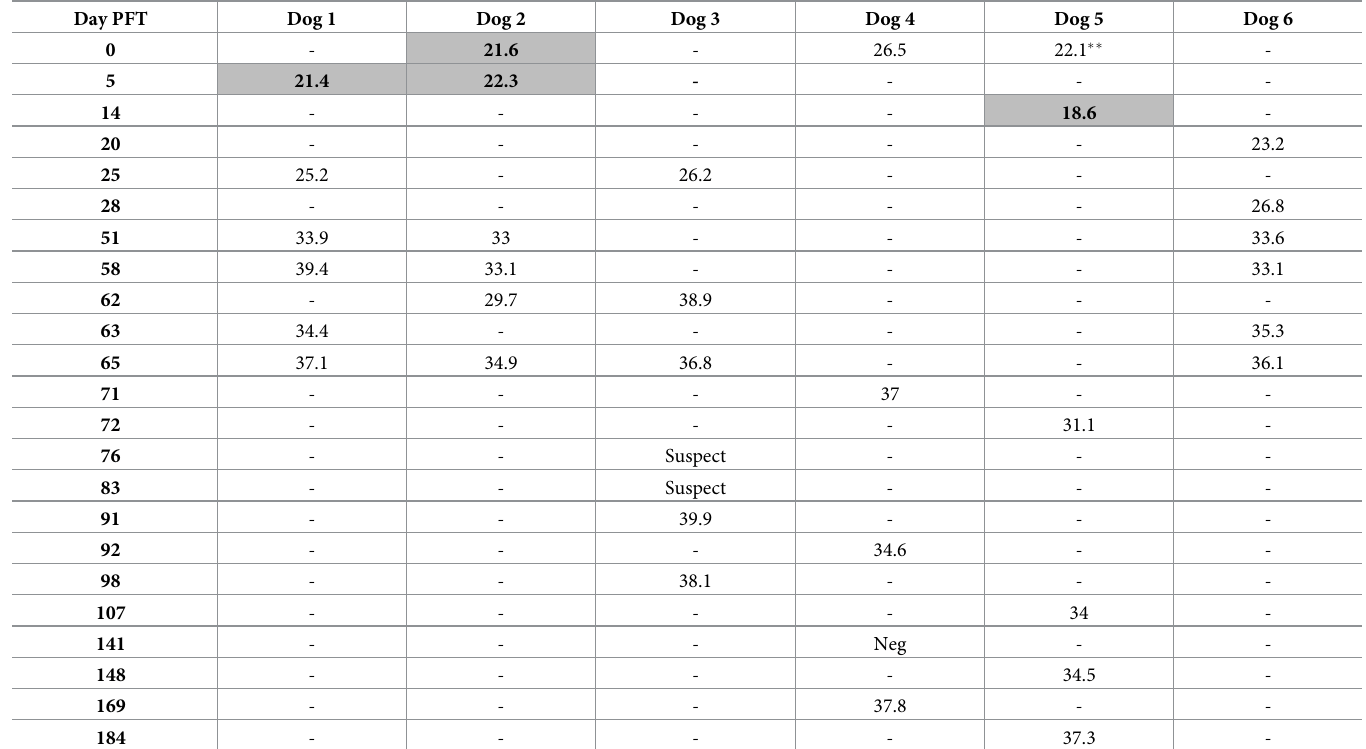
Table 2. Virus isolation results and Ct of samples taken over time for dogs 1–6.